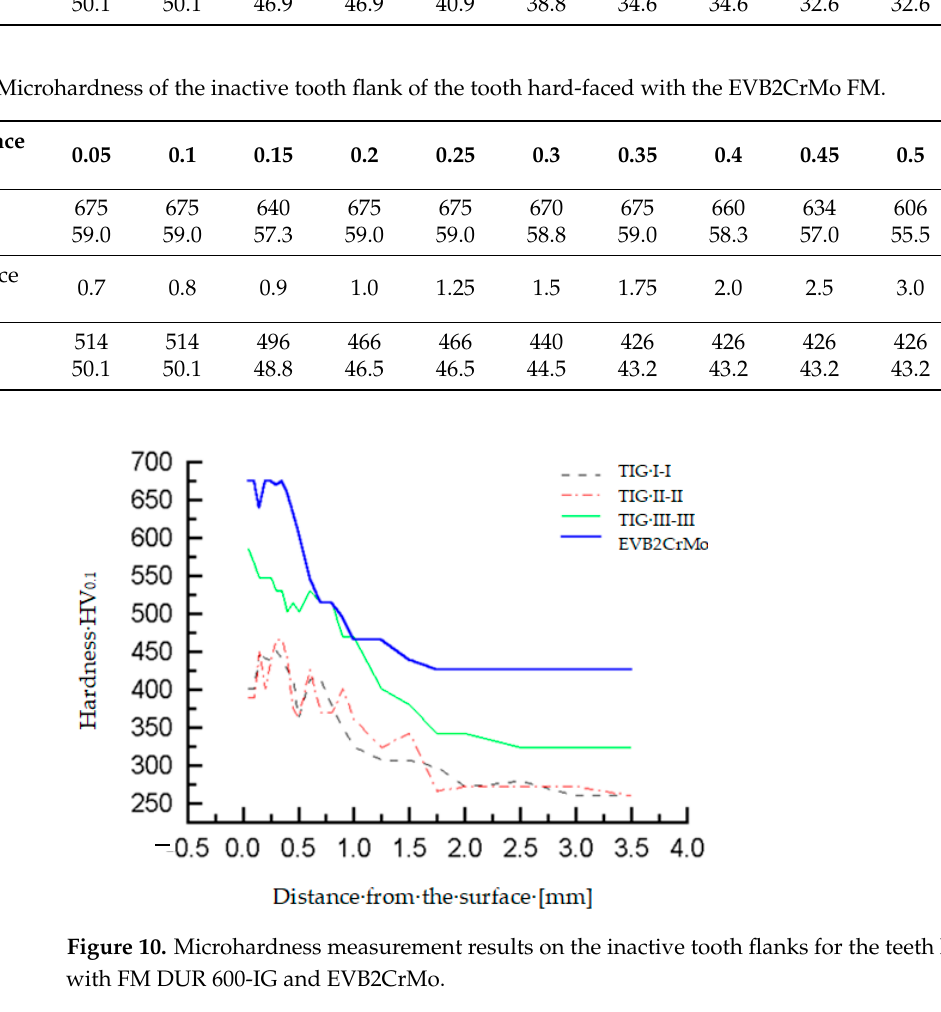
Table 9. Microhardness of the inactive tooth flank of the tooth hard-faced with the DUR 600-IG FM—direction III-III. Distance from the Surface (mm) Hardness HV 0.1 Corresponds to HRC Distance from the surface (mm) Hardness HV 0.1 Corresponds to HRC